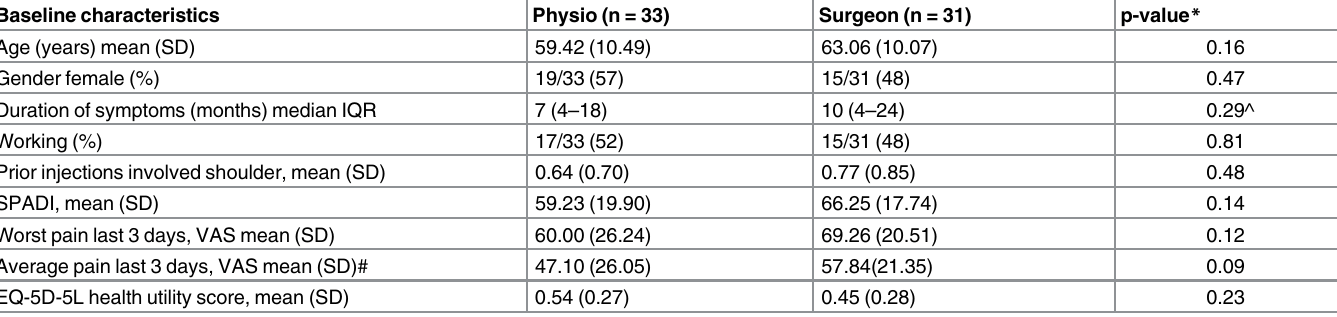
Table 1. Baseline characteristics of randomised participants.